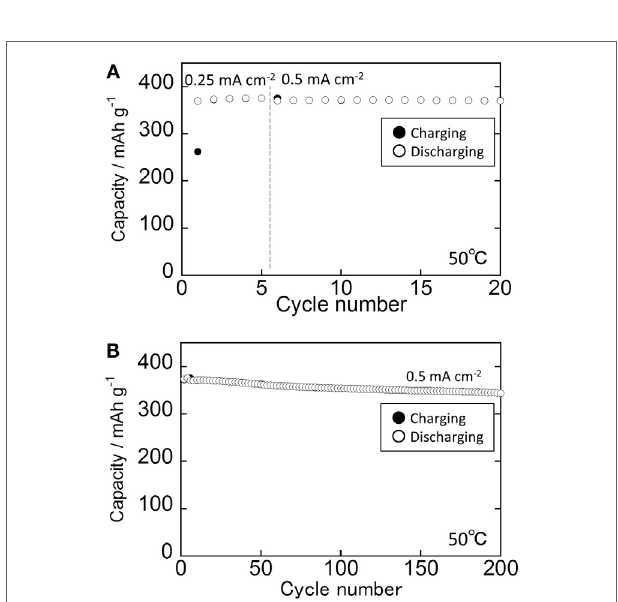
FigUre 7 | cycle performance of the all-solid-state li–in/li 3 nbs 4 cell . (a) 1st to 20th cycle and (B) 1st to 200th